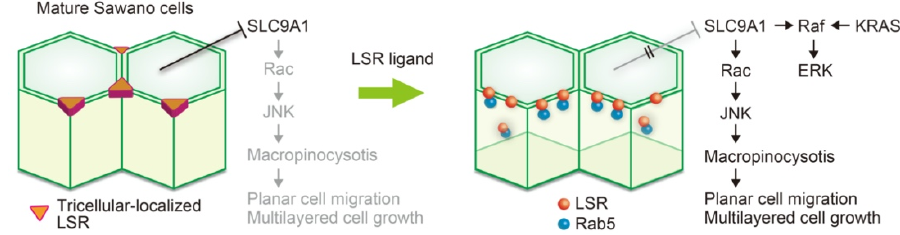
Figure 3. Schematic representation of the mechanism by which endometrial cancer Sawano initiates malignant cell growth. Mature epithelial sheets, where LSR localize at tricellular tight junctions, suppress macropinocytosis. LSR ligand administration leads to the translocation of LSR from tricellular tight junctions. LSR interacts with Rab5 in the bicellular region, resulting in decreased LSR expression. SLC9A1 is presumably activated through a signal that accompanies the alteration of LSR localization, followed by Rac activation. SLC9A1 scaffolds Raf and ERK downstream of KRAS. Activated Rac induces JNK activation, resulting in the formation of macropinocytosis, followed by an increase in planar cell migration, and eventually, multilayered cell growth.